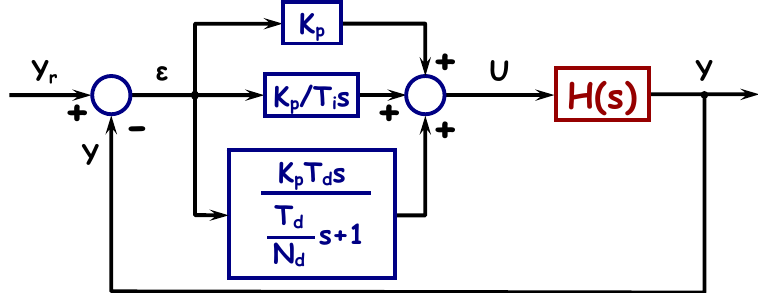
Figure 2. Regular, standard Proportional–Integral–Derivative(PID) structure (PID-R).